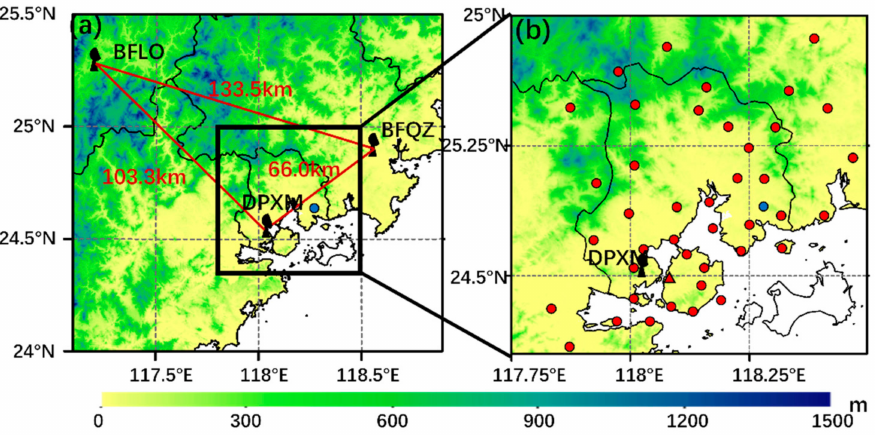
Figure 1. Multiple observations used in this study: ( a ) three operational S-band Doppler radars (DPXM, BFQZ, and BFLO); and ( b ) automatic weather stations (AWSs; indicated by red and blue dots) and a radiosonde (indicated by the red triangle). The blue dot in ( a ) indicates the site where the wind gust with a maximum speed of 34.3 m s − 1 was